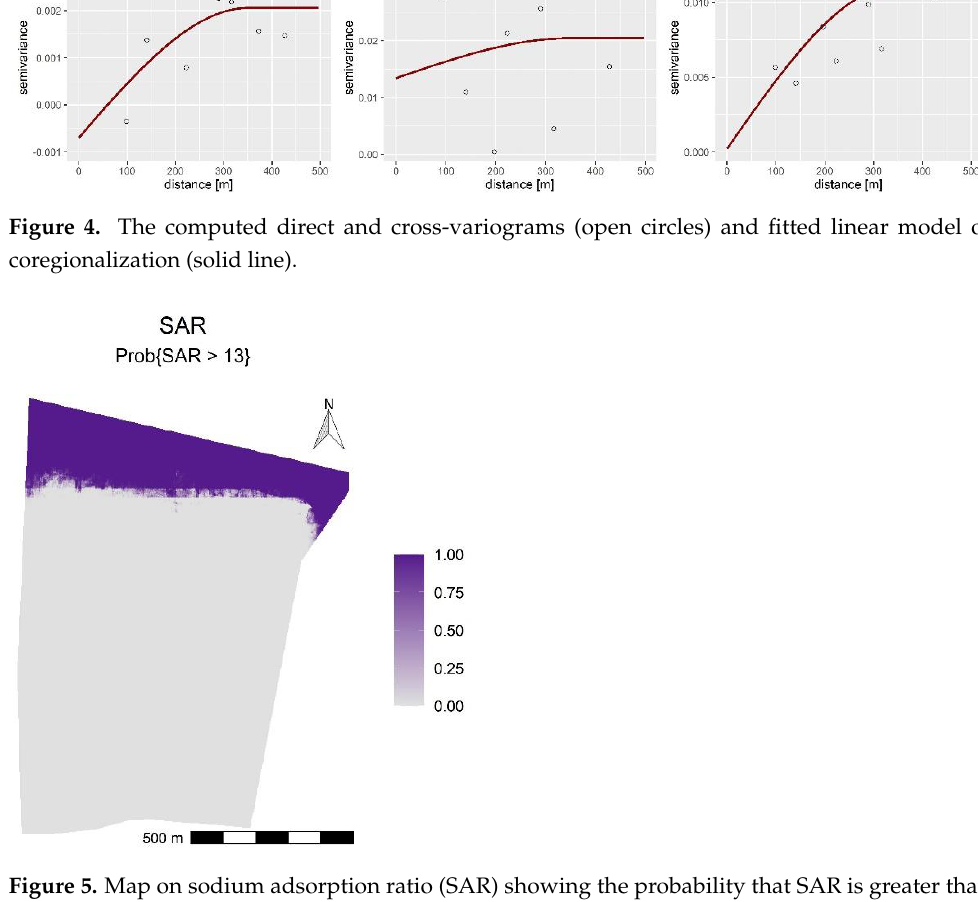
Figure 5. Map on sodium adsorption ratio (SAR) showing the probability that SAR is greater than the threshold value of 13.